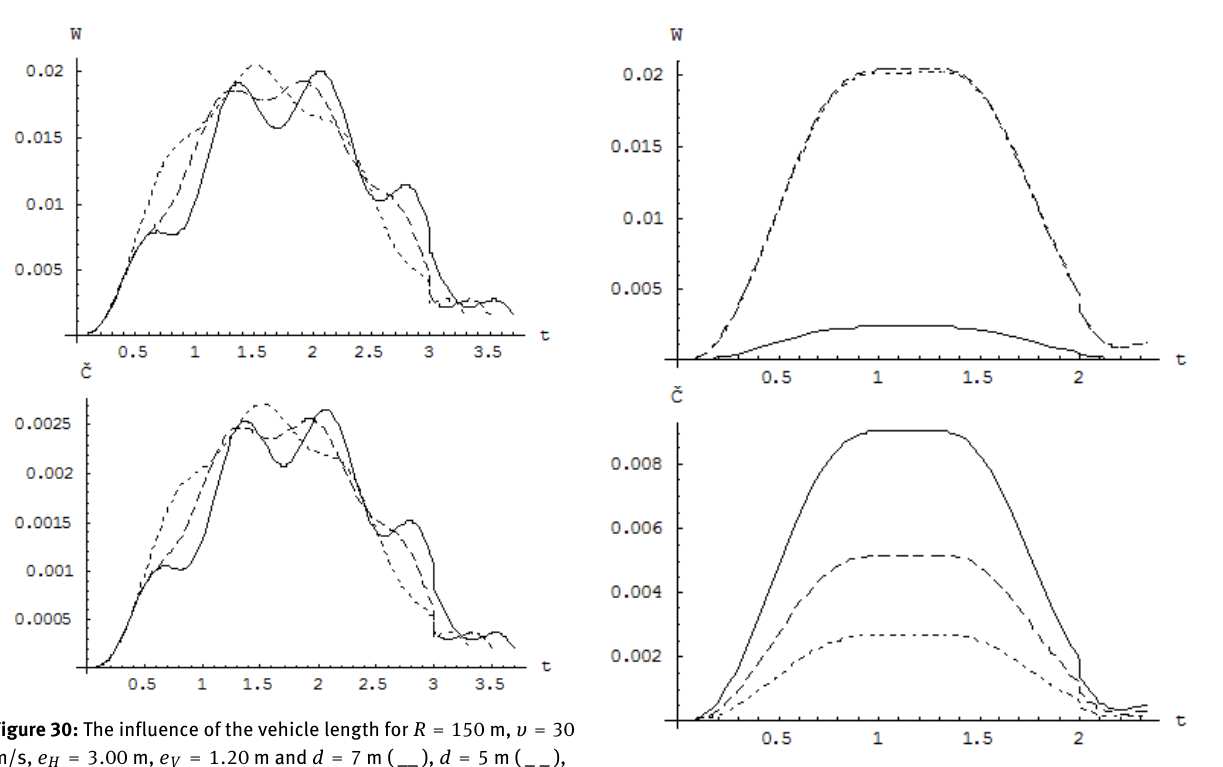
Figure 32: Influence of the radius of curvature R for d = 5 m, e H = 3.00 m, e V = 1.20 m υ = 30 m/s and R = 50 m ( __ ), R = 100 m ( _ _ ), and R = 150 m (- - -